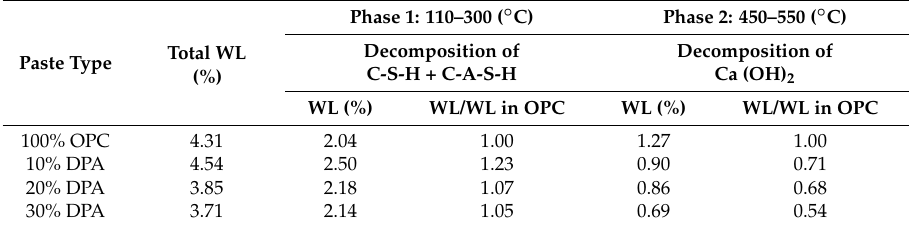
Table 2. Weight loss in paste mixtures at the age of 28 days.